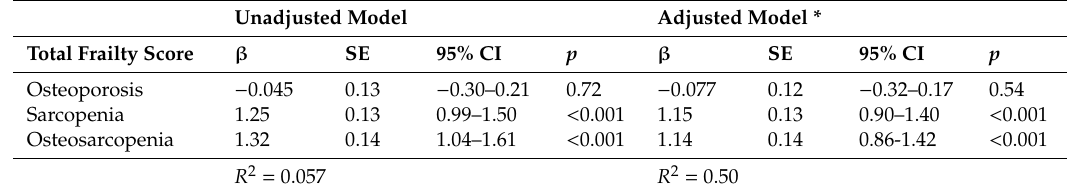
Table 2. Multiple linear regression models with total frailty score as the dependent